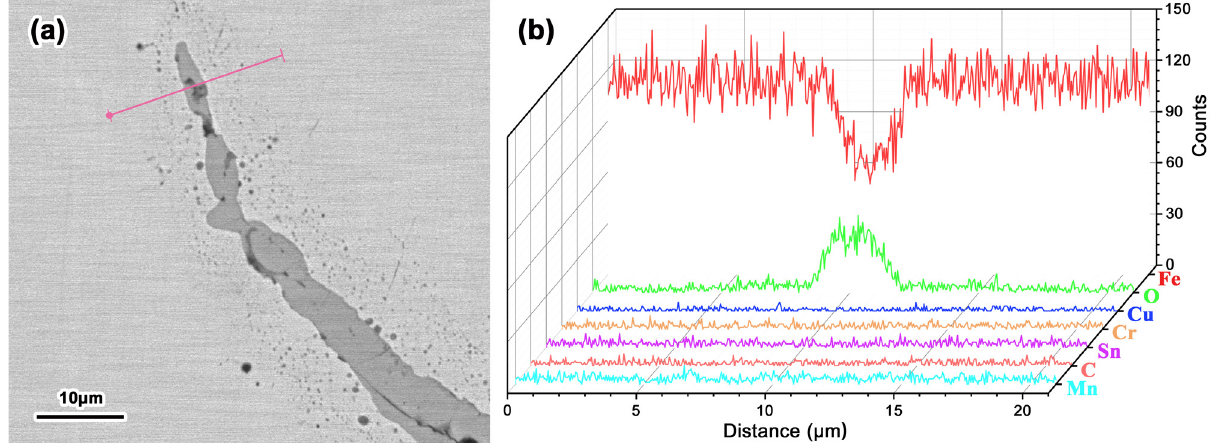
Figure 8: Line scanning analysis over the line shown in (a) for (b) Fe, O, Cu, Cr, Sn, C, and Mn.